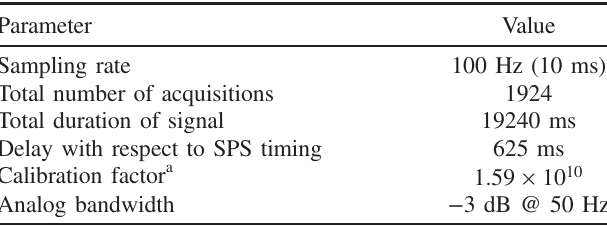
TABLE I. Main parameters of the BCT signals. The calibration factor is used as least significant bit (LSB), for the estimation of the quantization errors.